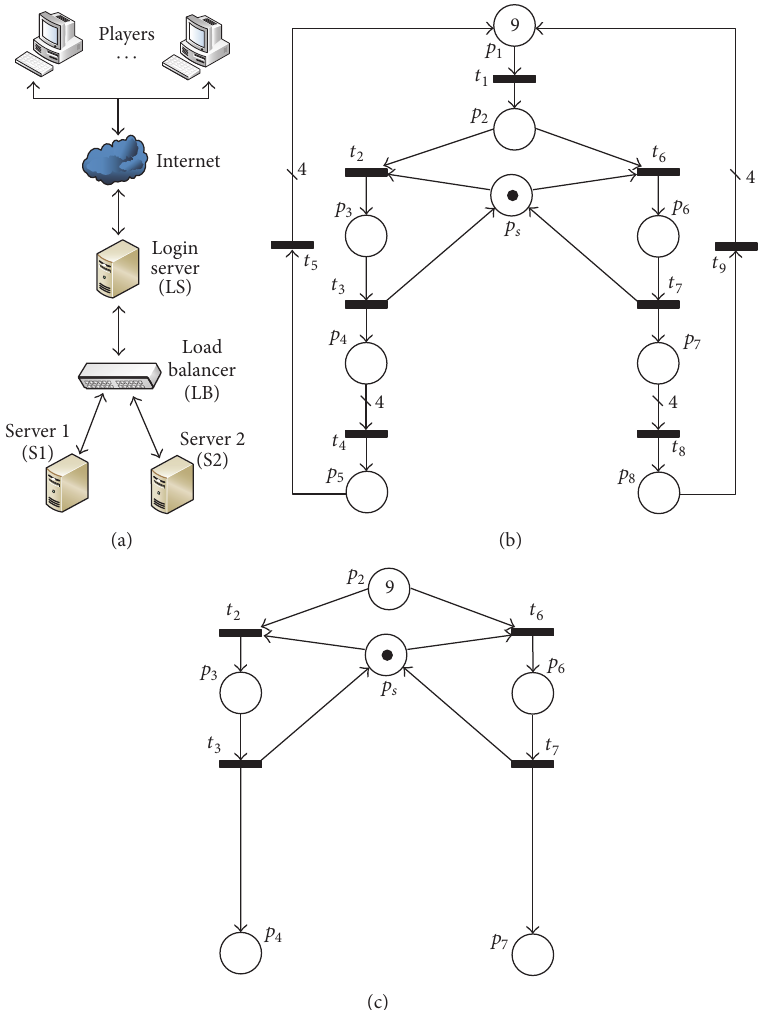
Figure 6: (a) The topology group of the server system of QQ Chinese Poker, (b) the Petri net model of the server system, and (c) the MESR of the server